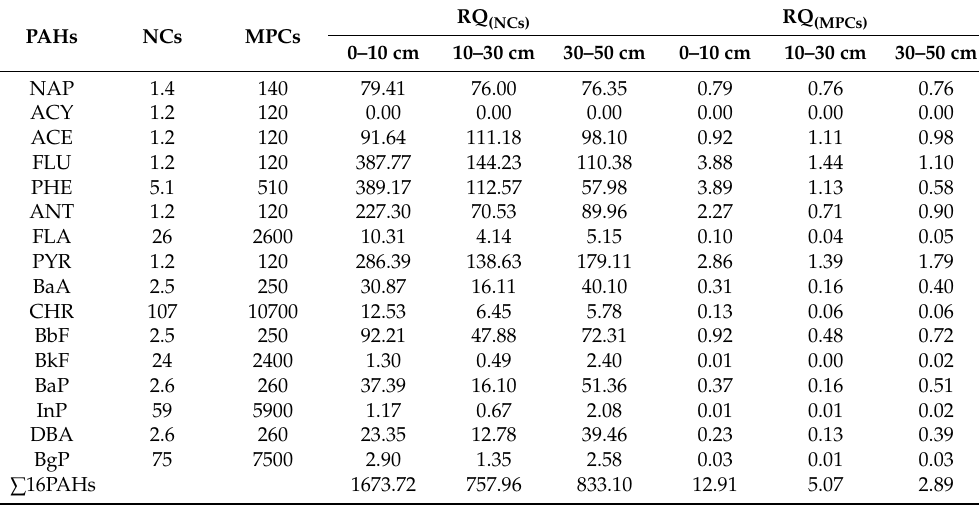
Table 5. Descriptive statistics of RQ(NCs) and RQ(MPCs) of PAHs in soils ( µ g/kg).